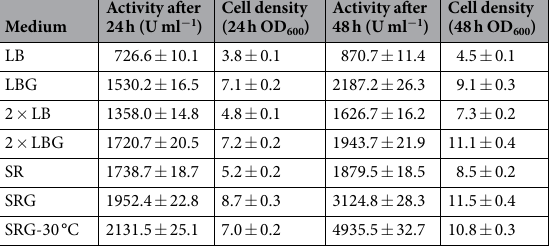
Table 5. Extracellular protease activity in different expression medium.